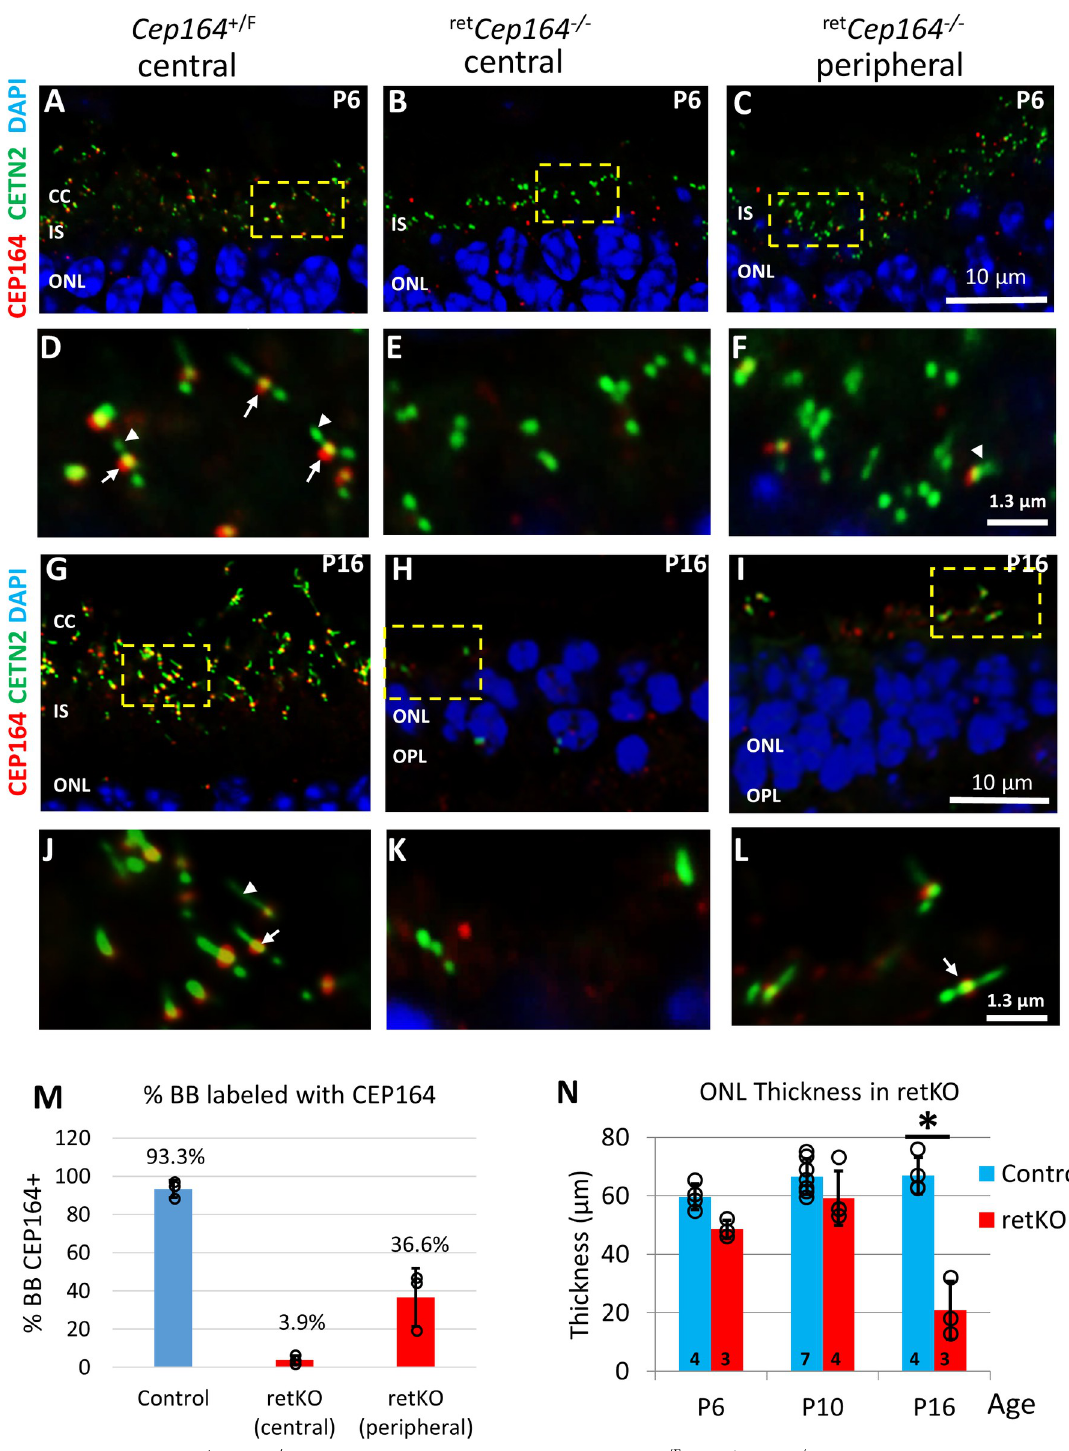
Fig 1. Rapid postnatal ret Cep164 -/- photoreceptor degeneration. A-C , P6 Cep164 +/F (A), ret Cep164 -/- central (B) and peripheral (C) cryosections on Egfp-Cetn2 + background probed with anti-CEP164 antibody (red). In ret Cep164 - /- cryosections, CEP164-BB association is much reduced, but not in retina periphery where degeneration is delayed. D-F , enlargements of A-C as indicated. CEP164 associates with the BB (arrows) in control sections (D), is absent in the knockout (B’), but detectable at some BB in the retina periphery (F). Arrowheads identify CC. G-I , P16 cryosections probed with anti-CEP164 antibody. Note reduced thickness of mutant ONL. J-L , enlargements as indicated in G-I. At P16, control CC (G, J) are normal length and CEP164 is firmly associated with the BB (arrows in